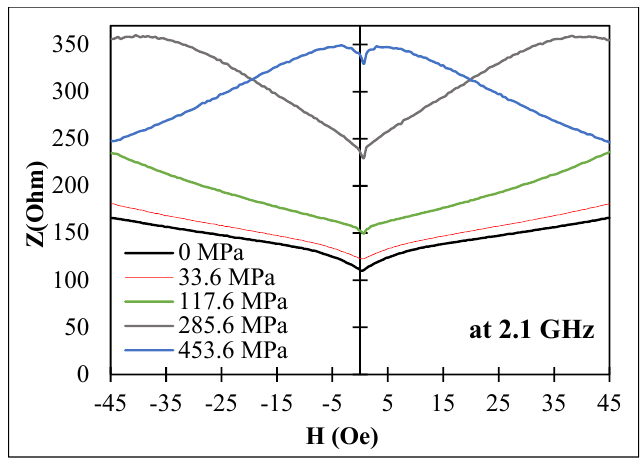
Figure 15. Effect of a tensile stress on the MI vs. magnetic field behavior for amorphous Co 71 Fe 5 B 11 Si 10 Cr 3 microwires (sample No3) after DC current annealing at 90 mA for 30 min at a frequency of 2.1 GHz. Z corresponds to the impedance amplitude.